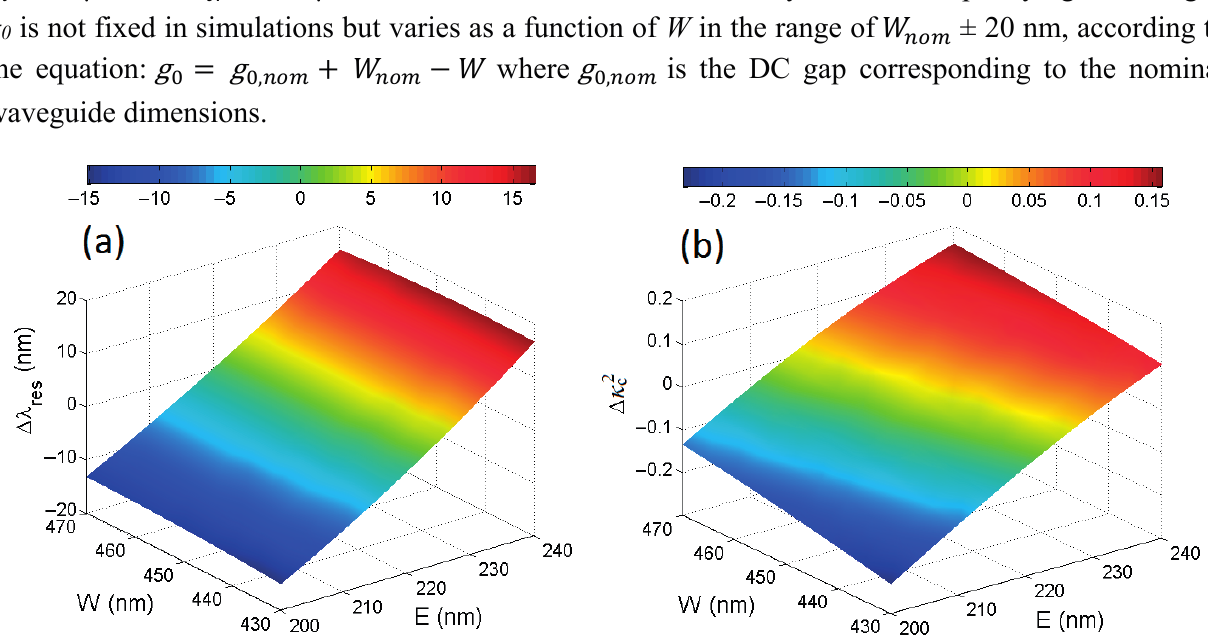
(cid:3045)(cid:3032)(cid:3046)